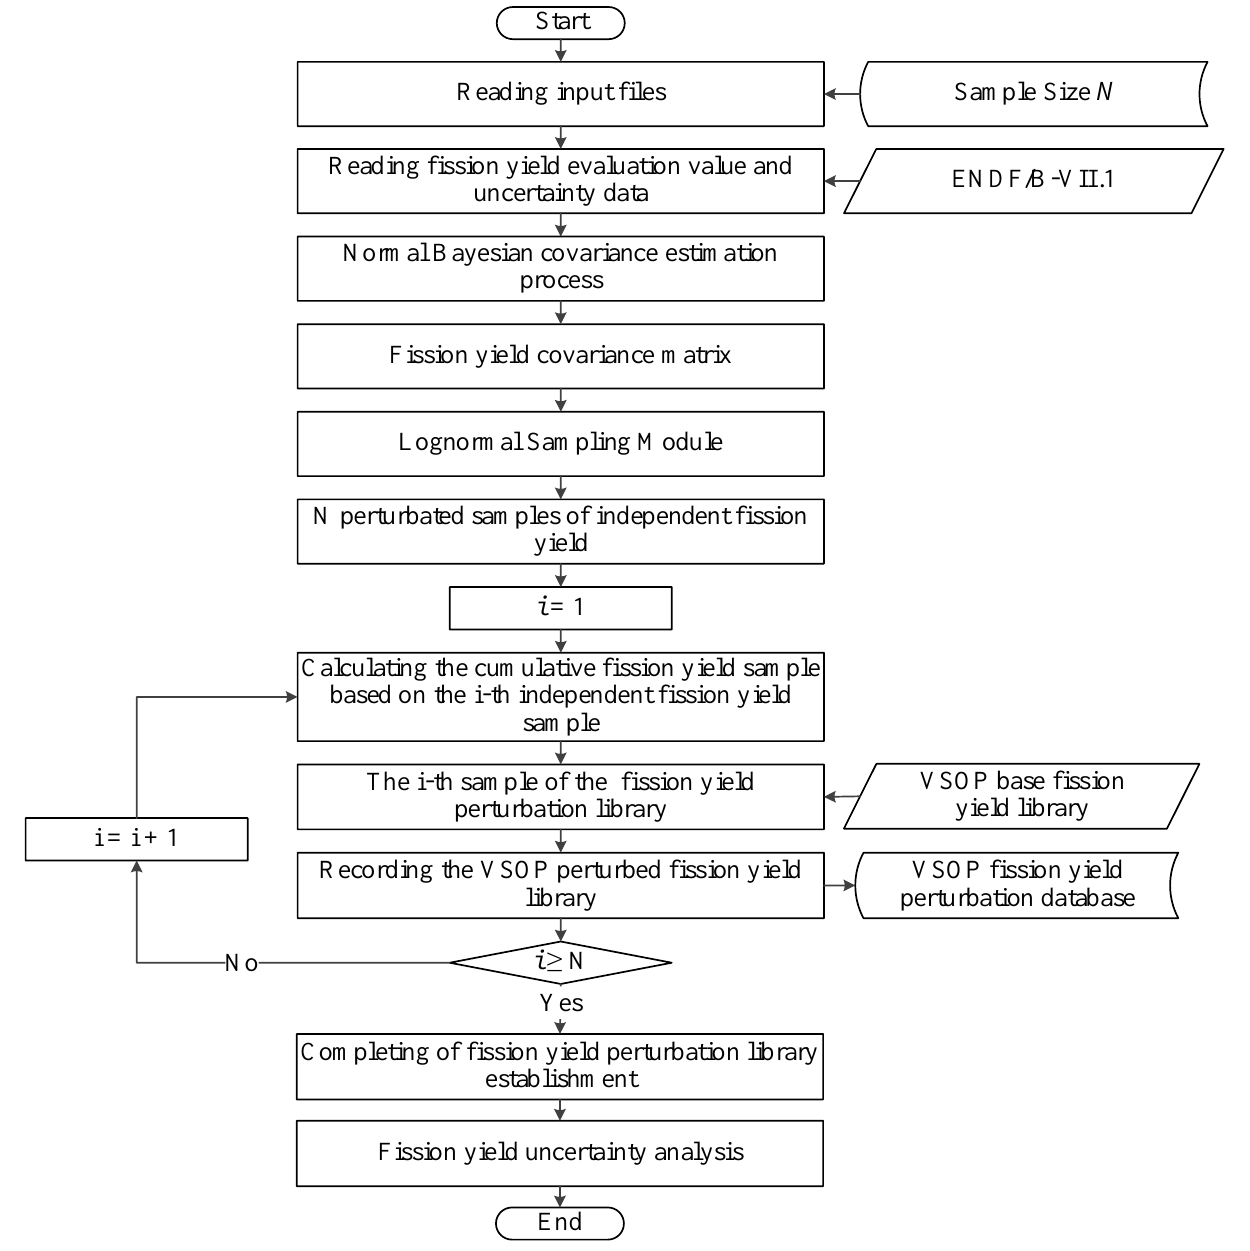
Figure 4. VSOP – UAM fission product yield uncertainty analysis flowchart. Figure 4. VSOP–UAM fission product yield uncertainty analysis